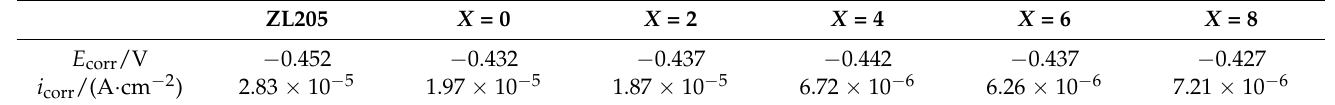
Figure 8. Potential polarization curve of the ZL205 alloy after the addition of the Al-TiO 2 -C-XEr 2 O 3 refiner. Table 4. Electrochemical parameters of the ZL205 alloy after the addition of different Er 2 O 3 refiners.